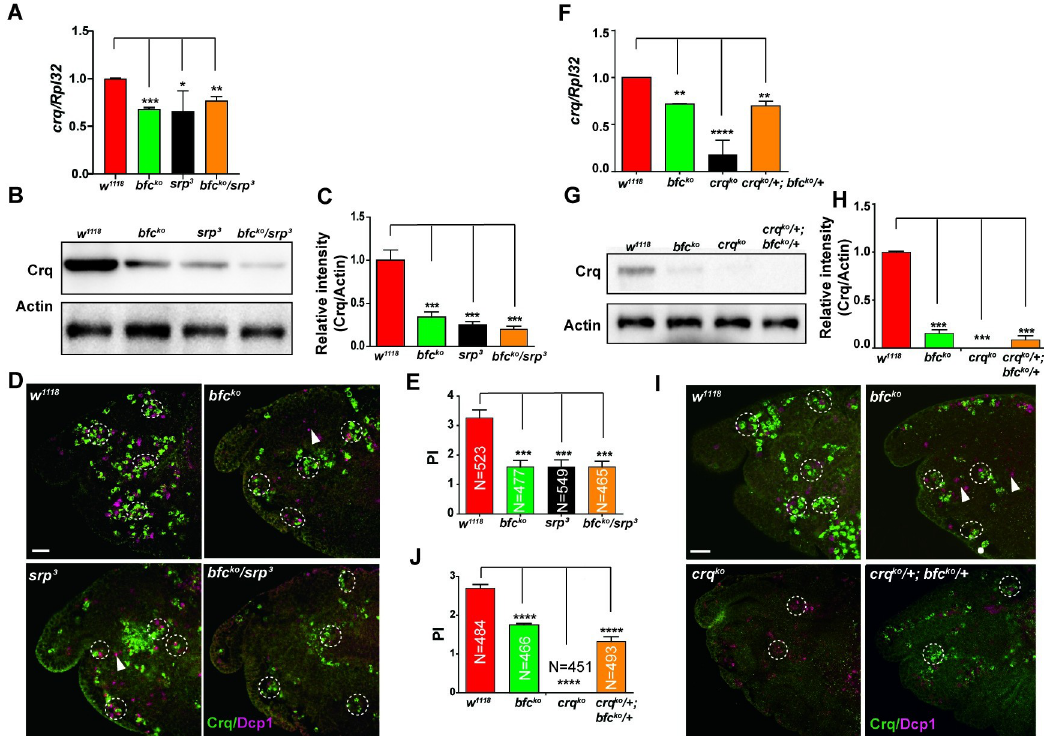
Fig 5. Bfc interacts with Srp to regulate crq expression and efferocytosis. A. The relative crq mRNA levels were quantified by qPCR in macrophages obtained from wild-type, homozygous bfc ko or srp 3 , and double heterozygous bfc ko and srp 3 stage 13 embryos. B. Western blot analysis of the Crq protein levels in macrophages of wild-type, homozygous bfc ko or srp 3 , and double heterozygous bfc ko and srp 3 stage 13 embryos. Actin was used as the loading control. C. Quantification of the Crq protein levels in (B) after normalization to the Actin levels; n = 3. D. Macrophages of wild-type, homozygous bfc ko or srp 3 , and double heterozygous bfc ko and srp 3 stage 13 embryos were stained with anti-Crq (green) and anti-Dcp1 (magenta) antibodies. Scale bar = 20 μ m. E. Graph showing the mean PIs ± SEM for each genotype in ( D ). F. The relative crq mRNA levels were quantified by qPCR in macrophages of wild-type, homozygous bfc ko or crq ko , and double heterozygous bfc ko and crq ko stage 13 embryos. G. Western blot analysis of the Crq protein levels in macrophages of wild-type, homozygous bfc ko or crq ko , and double heterozygous bfc ko and crq ko stage 13 embryos. Actin was used as the loading control. H. Quantification of the Crq protein levels in ( G) after normalization to the Actin levels; n = 3. I. Macrophages of wild-type, homozygous bfc ko or crq ko , and double heterozygous bfc ko and crq ko stage 13 embryos were stained with anti-Crq (green) and anti-Dcp1 (magenta) antibodies. Scale bar = 20 μ m. J. Graph showing the mean PIs ± SEM for each genotype in ( I ). Statistical significance was assessed using the one-way ANOVA.